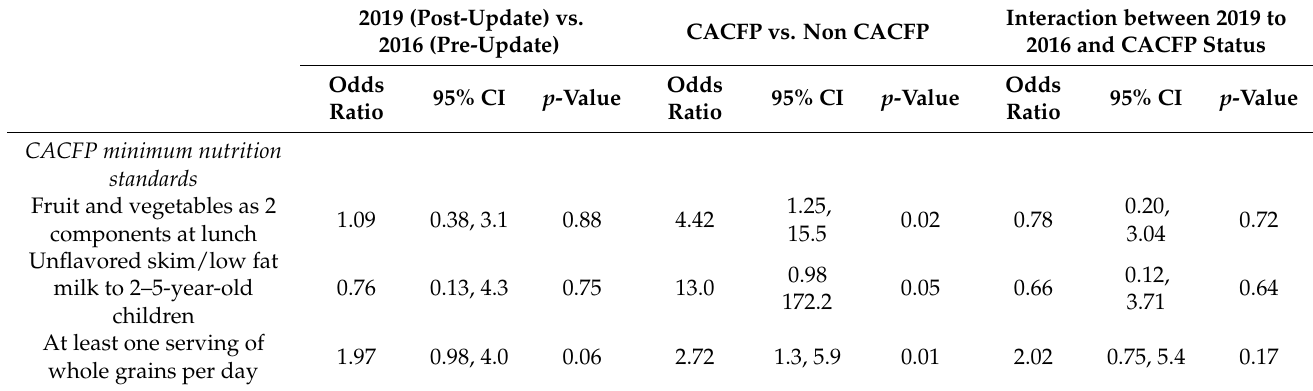
Table 3. Difference-in-difference model results: centers servings meals or meals and snacks. 2019 (Post-Update)